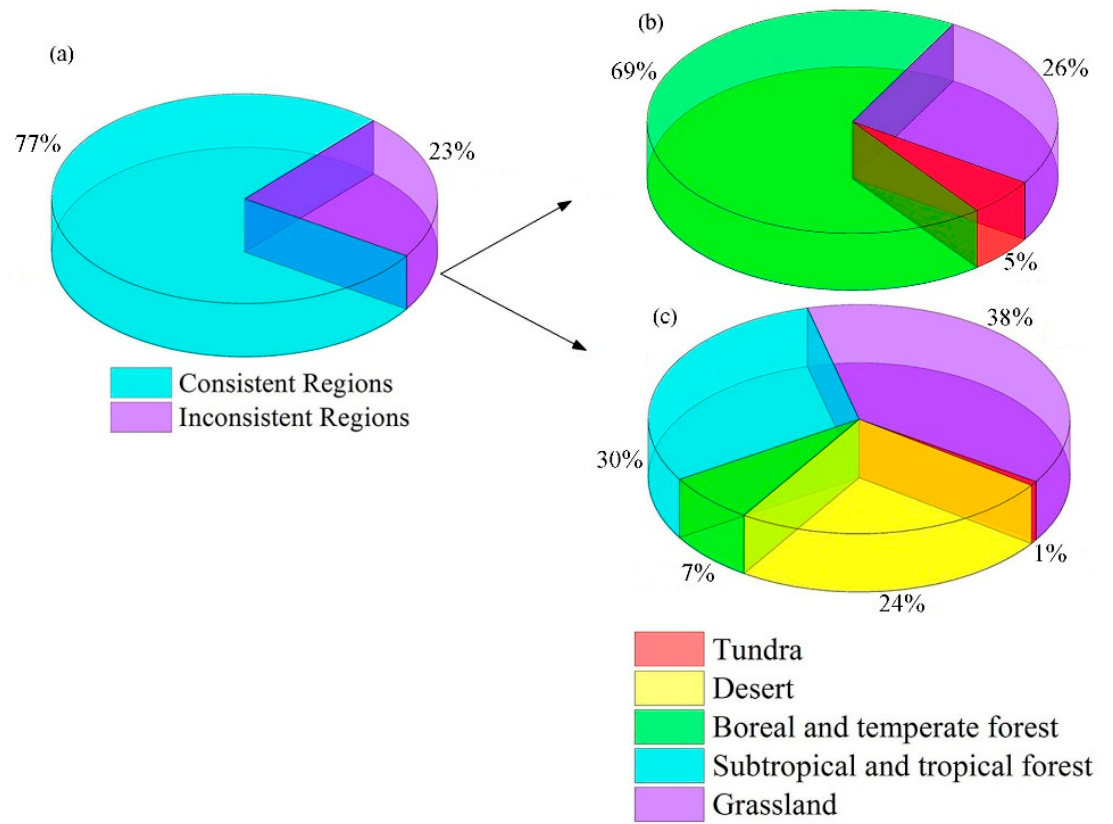
Figure 9. The 3D color pie charts for percentage of consistent class. Inconsistent class based on the CSCS model and HLZ model ( a ), percentage of inconsistent regions for each class based on CSCS model ( b ), and percentage of the inconsistent pixels for each class based on HLZ model ( c ) in the baseline scenario.